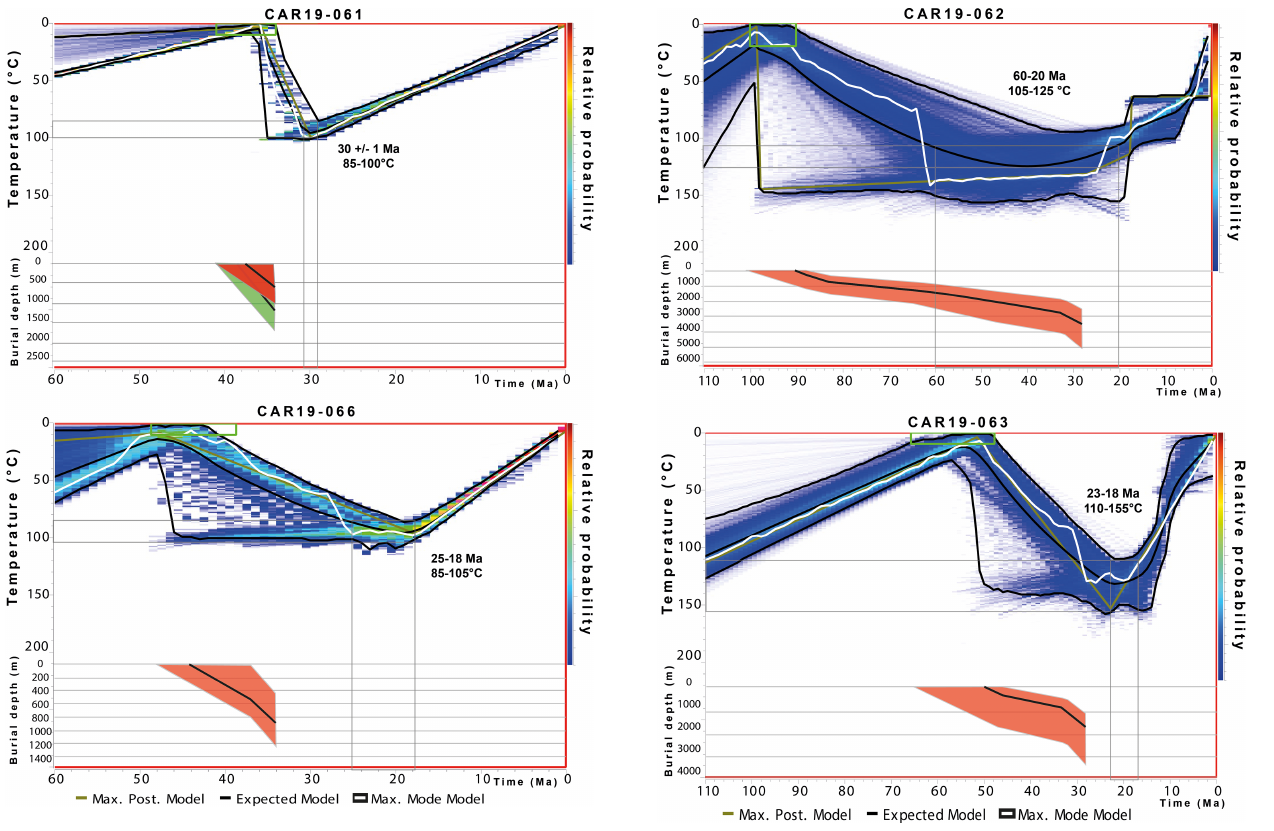
Figure 7. Modeled thermal histories and associated burial diagrams for samples CAR19-062 and 063 from the Burkut nappe. Peak burial temperature and time are highlighted by grey